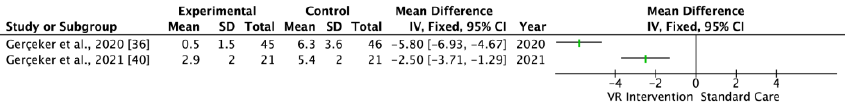
Figure 6. Comparison of VR treatment and standard care, anxiety (CAM). SD: standard deviation; 95% CI: 95% confidence interval. Without pooling due to heterogeneity (I 2 = 93%).